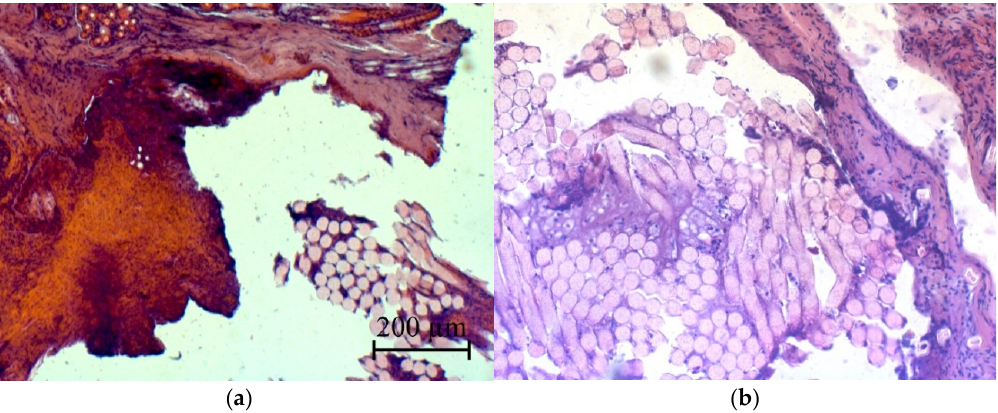
Figure 24. Micrographs of histological sections of postoperative wounds of laboratory animals (fragments of suture material): ( a )—the second group and ( b )—the third group.